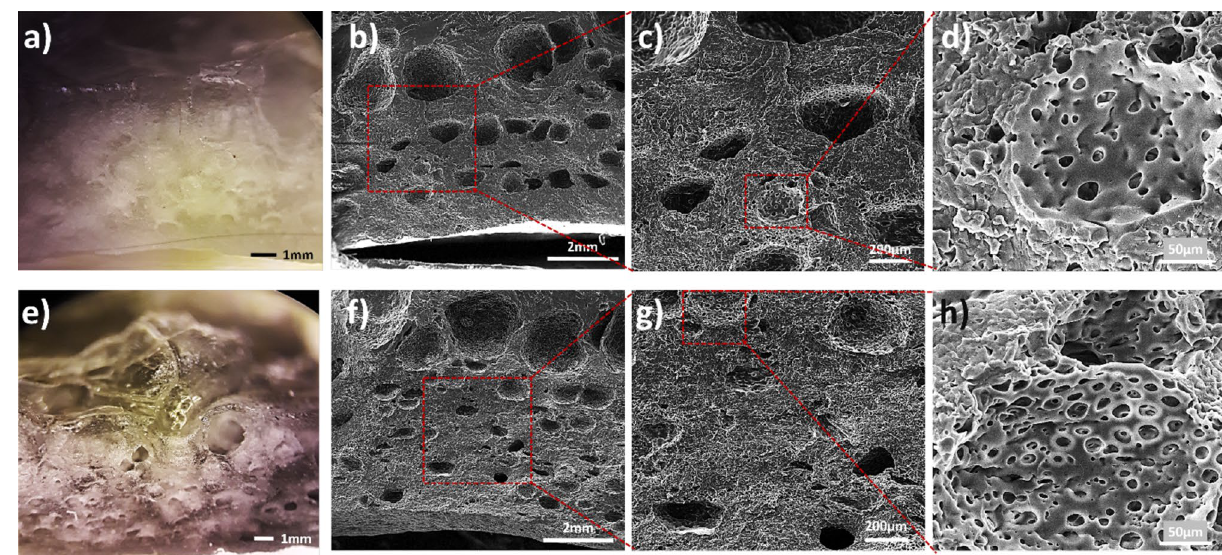
Figure 1. Optical ( a , e ) and SEM ( b – d , f – h ) images of the cross-section of pure porous PDMS (top row) and CNT-PDMS (bottom row)